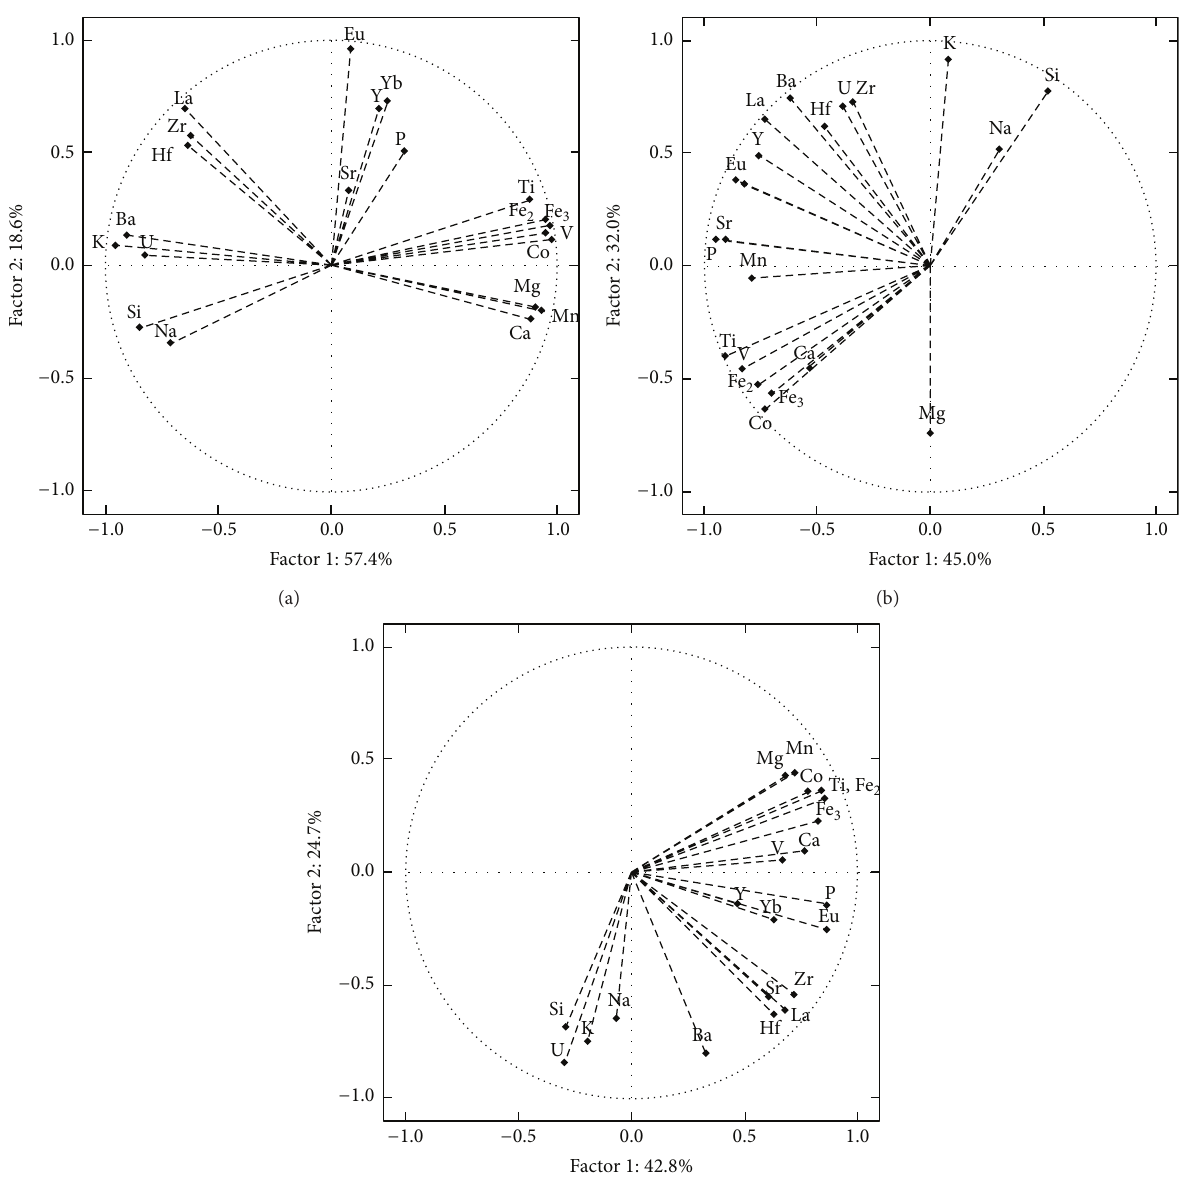
Figure 10: Projection of the variables on the factor-plane F2-F1 generated by principal component analysis (PCA) for the Sierra de las Cruces sectors: (a) northern, (b) central, and (c) southern +